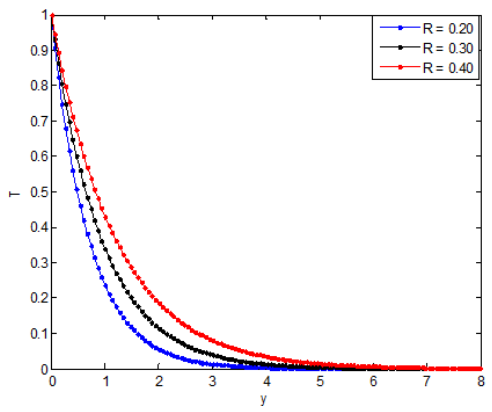
Figure 7. Effects of radiation parameter on temperature profile of the Casson nanofluid